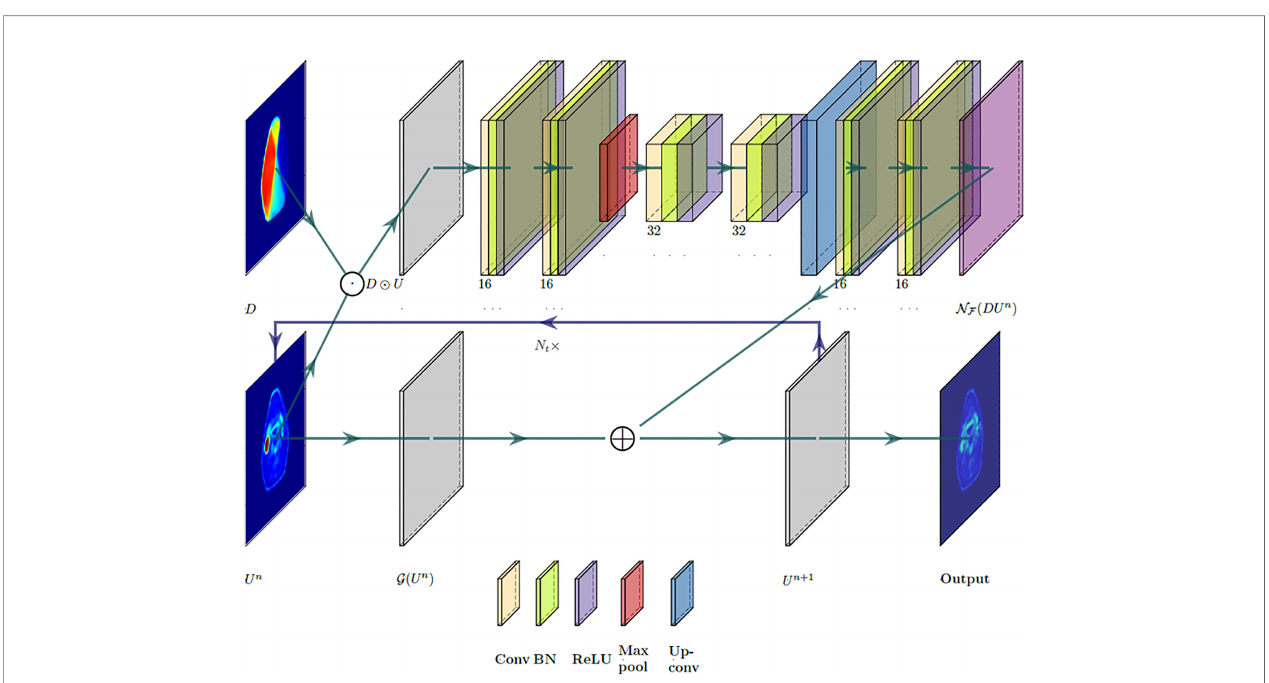
FIGURE 1 | A partial differential equation (PDE)-informed deep neural network design. Layers are color-coded by operations with associated feature